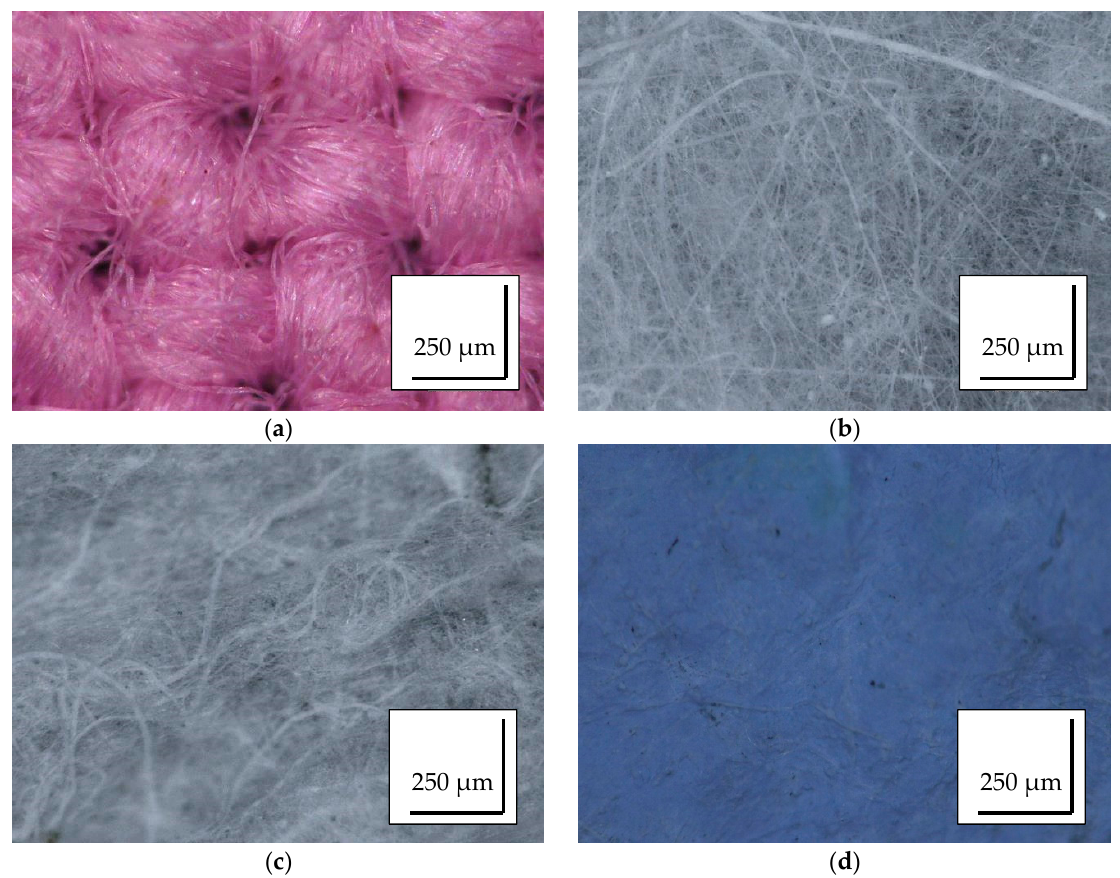
Figure 2. Microscopic images of ( a ) a cotton fabric dyed with anthocyanins; ( b ) a PAN / ZnO nanofiber mat; ( c ) a PAN / ZnO nanofiber mat dyed with anthocyanins; ( d ) a PAN / ZnO nanofiber mat dip-coated in ZnO and dyed with anthocyanins.